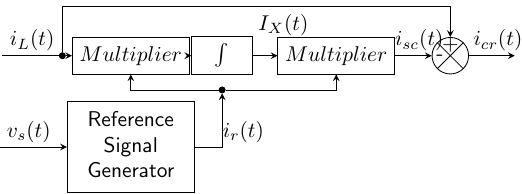
Figure 9. Block diagram of Sine-Multiplication